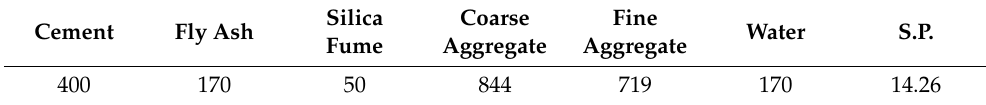
Table 1. HSC concrete mix proportion (kg/m 3 ).